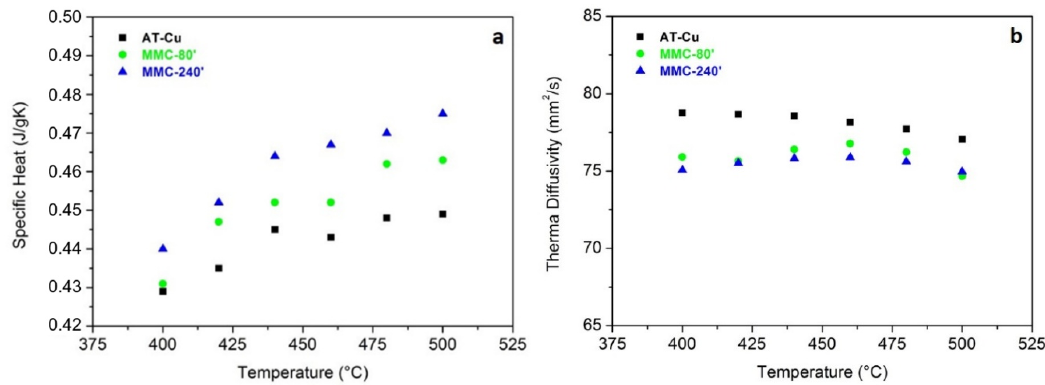
Figure 8. Specific heat ( a ) and thermal diffusivity ( b ) of sintered samples.